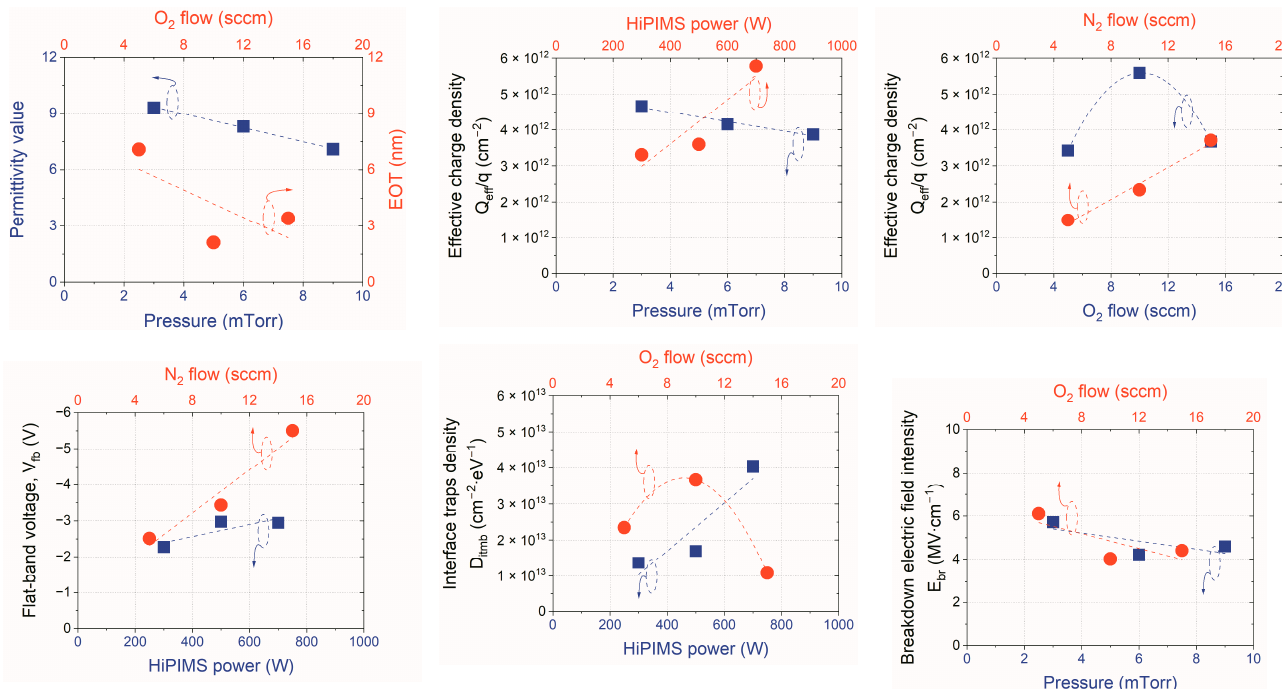
Figure 1. Graphing methodology used in orthogonal tables, employed during the analysis of dependencies between process and material parameters; the example shows the trend (dashed line) of the in fl uence of pressure in the reactive chamber on the permi tt ivity value of HfO x N y fi lms (see Figure 2).